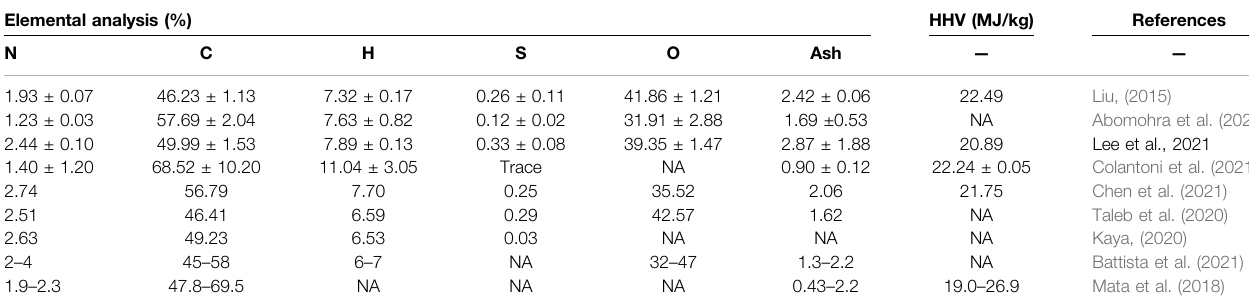
TABLE 1 | Recent studies on elemental compositions of